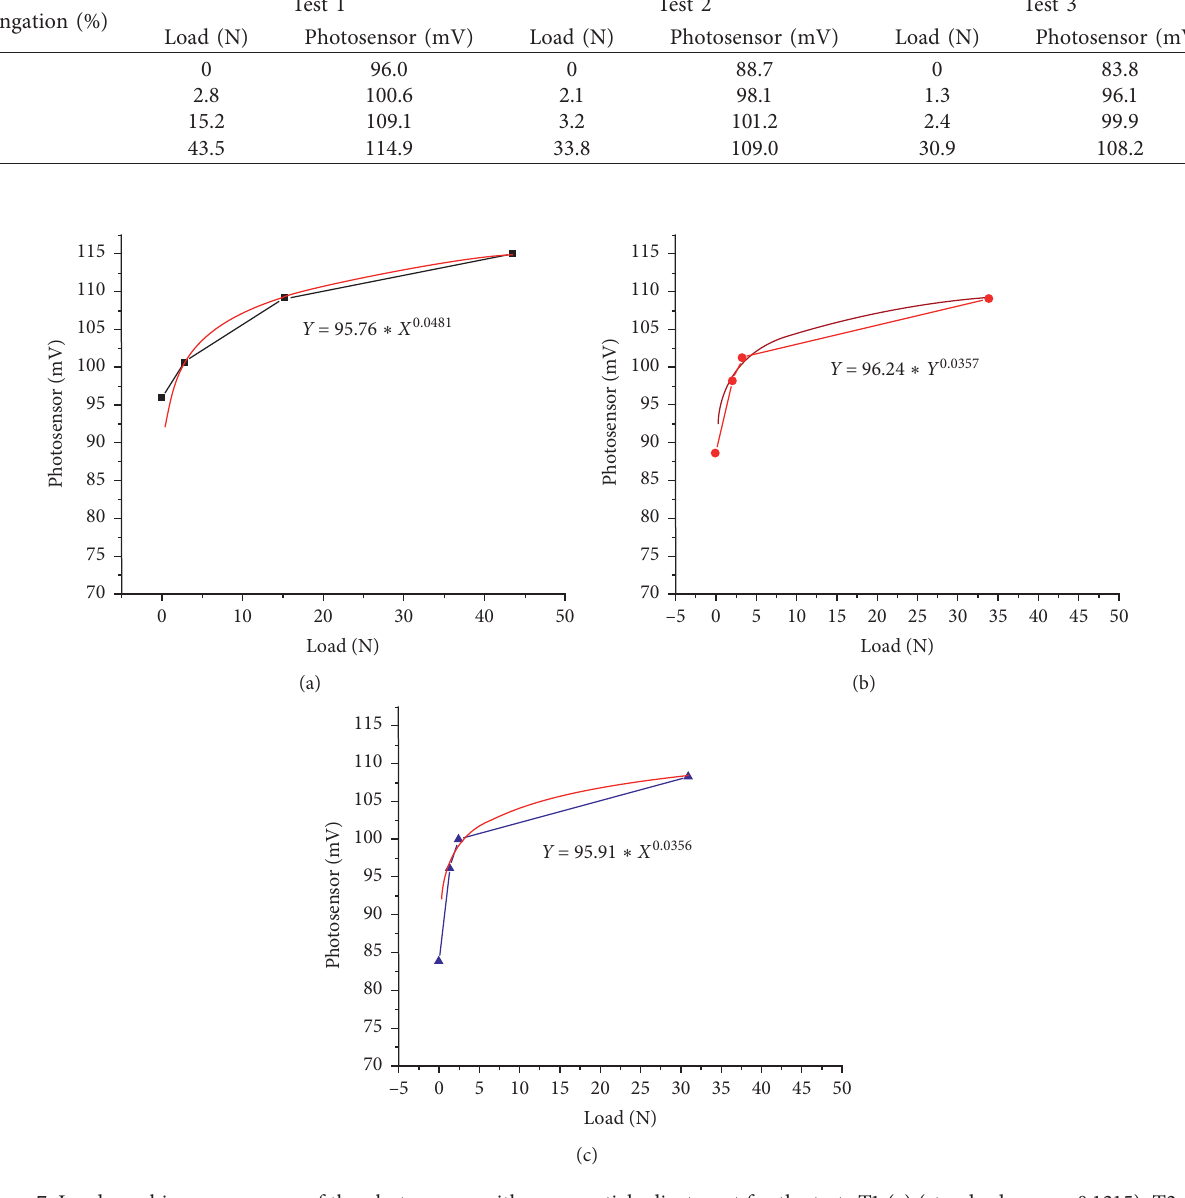
Table 1: Load and response of the photosensor for an elongation of 0%, 10%, 20%, and 30%. Elongation